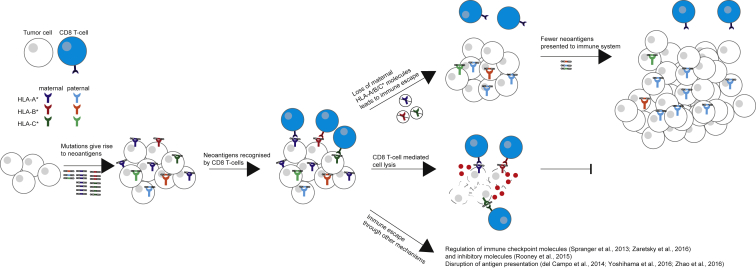
Model of HLA Allele-Specific Loss in NSCLCModel illustrating how HLA LOH may lead to immune escape in tumors. During tumor evolution, the accumulation of neoantigens may induce local immune infiltrates, including CD8 T cells. Local immune infiltrates may act as a selection barrier for tumors. Subclones with HLA LOH may be positively selected as these can evade killing by avoiding CD8 T cell recognition. Alternatively, other subclones may evade killing through other mechanisms.